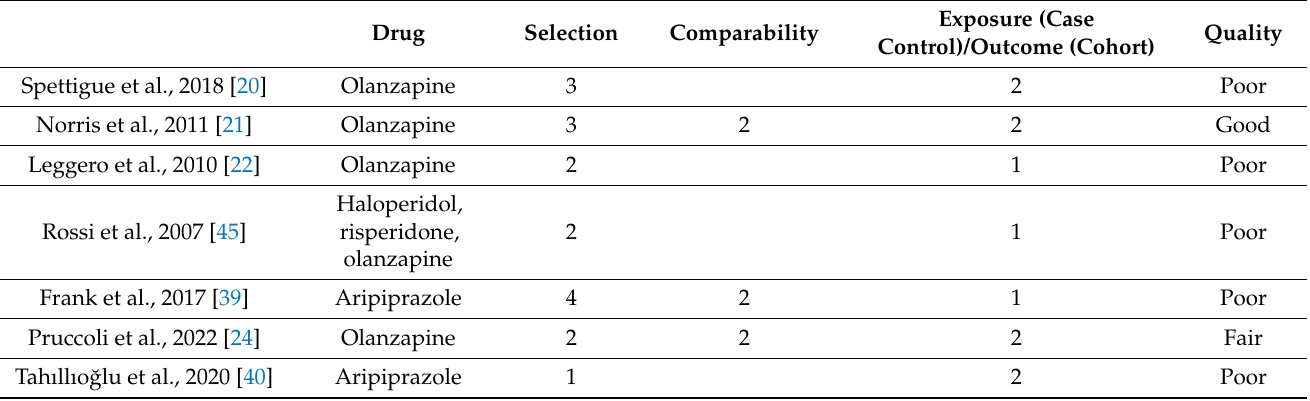
Table 2. Quality assessment of the included studies (case reports excluded). For each included study, the Risk of Bias score and Quality assessment is reported, according to